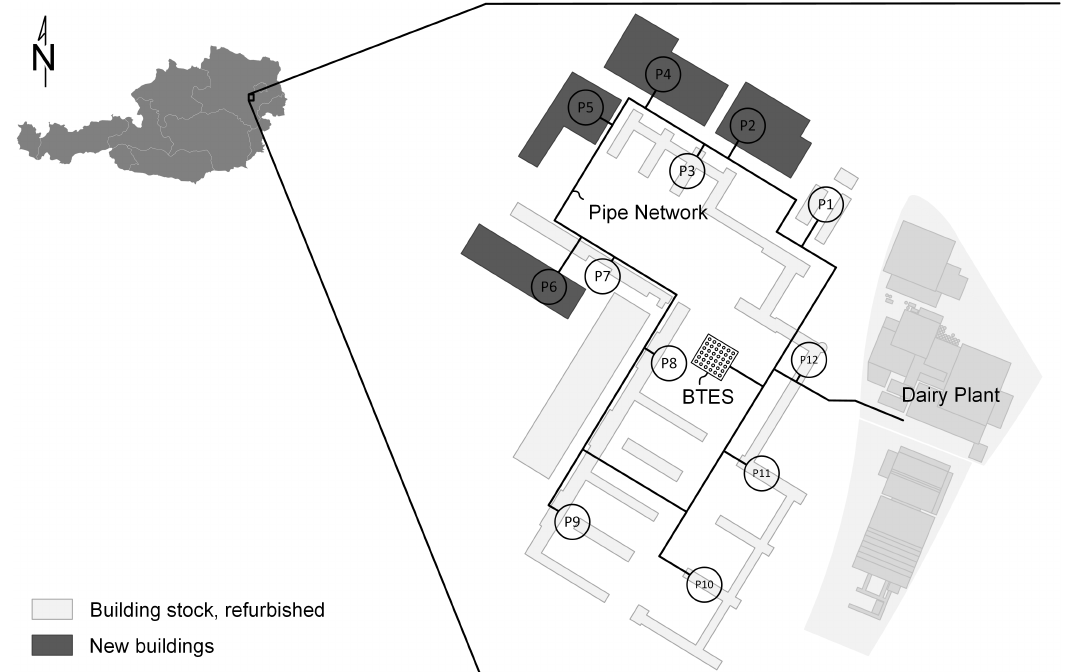
Figure 10. Area of interest in SANBA - scenario MIDI: ground view of buildings, pipe network, BTES and